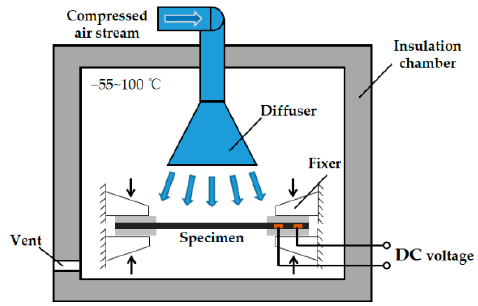
Figure 2. Dimensions of specimens: ( a ) specimen used in temperature and static tensile tests; ( b )